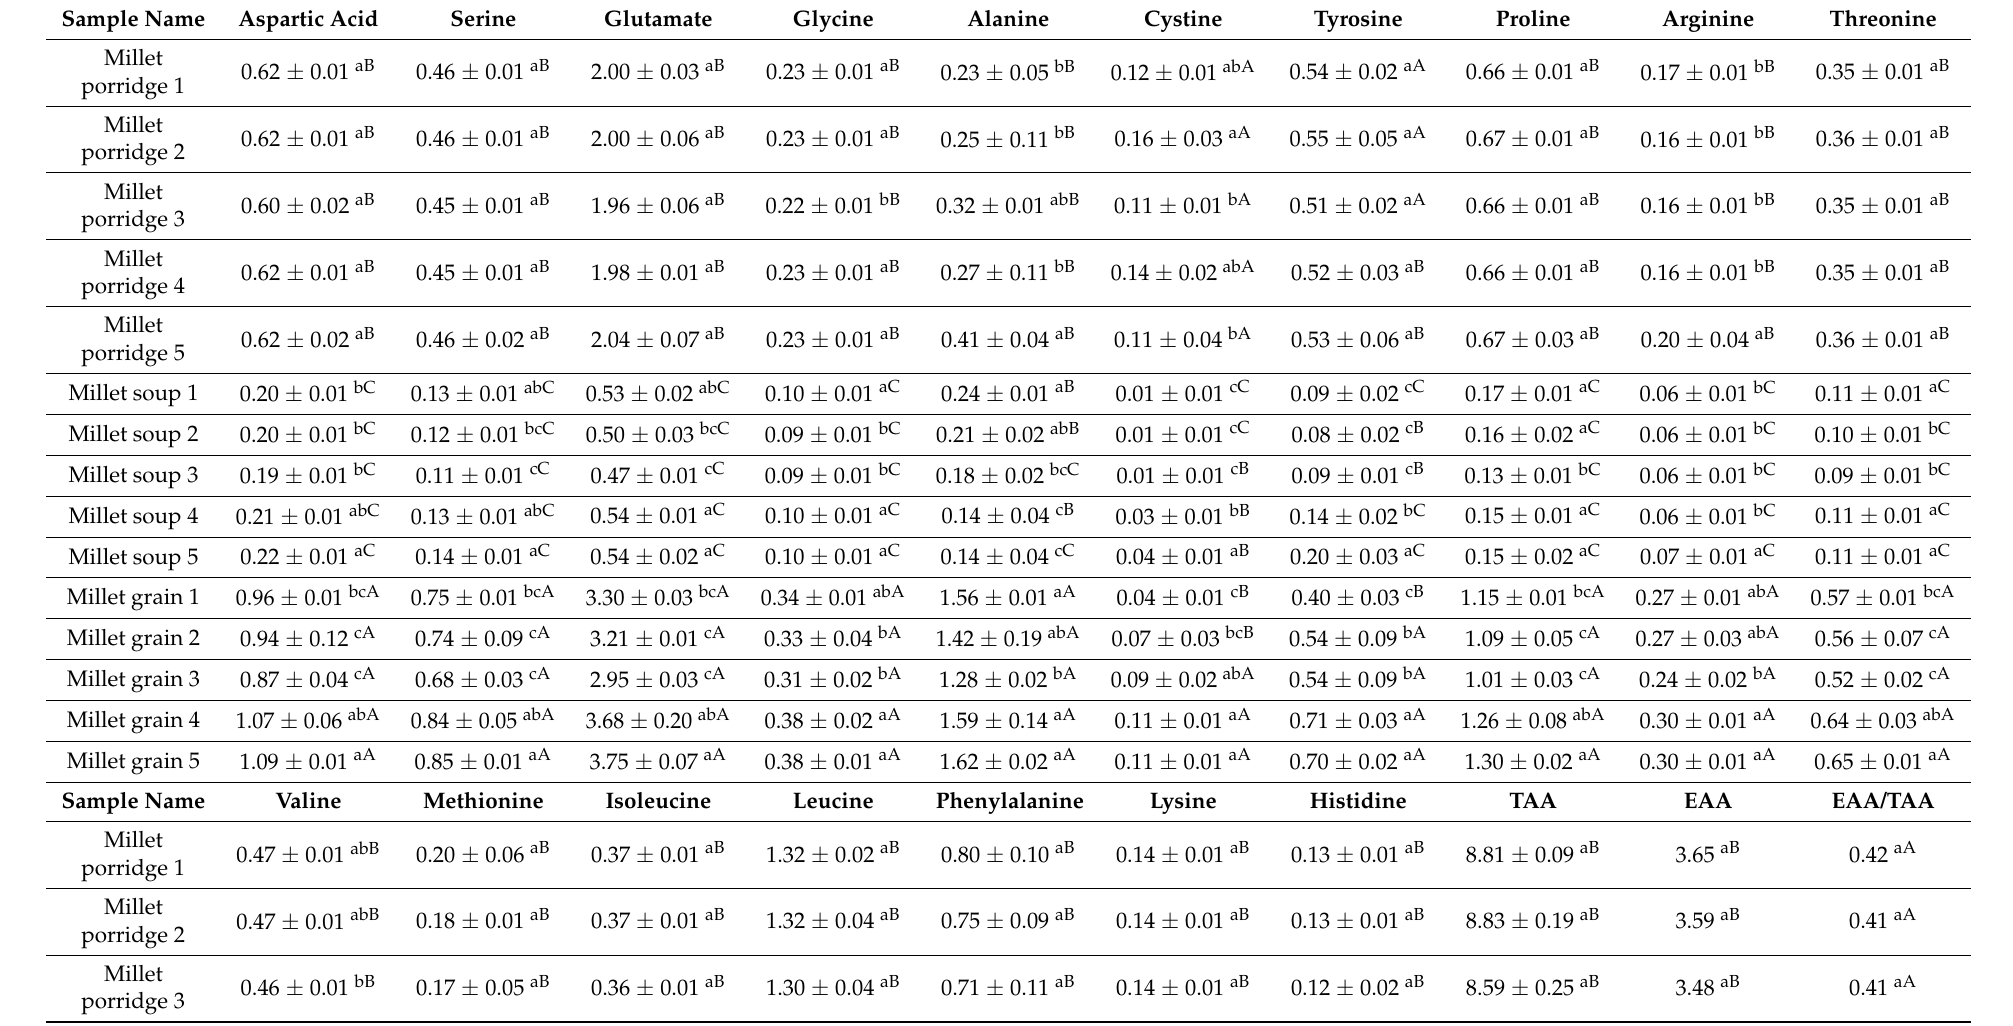
Table 5. Amino acid content of millet porridge cooked in different electric